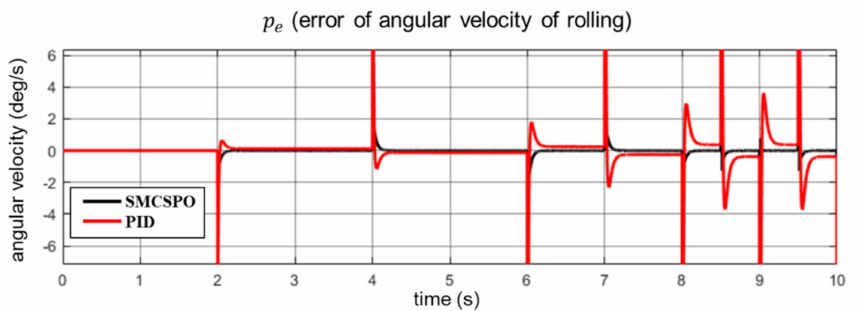
Figure 6. Rolling velocity’s error comparison of SMCSPO and PID controller without